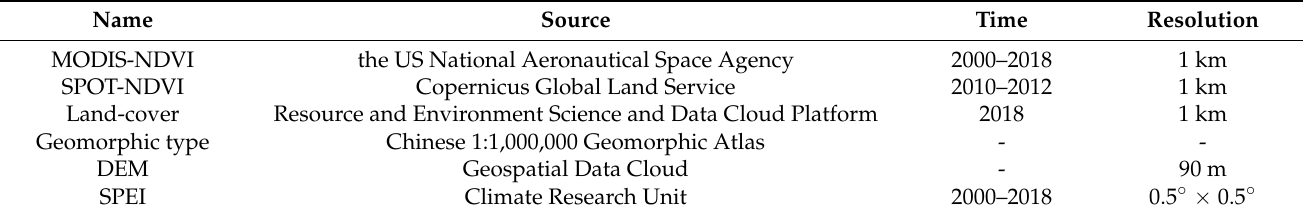
Table 1. The information of datasets used in this